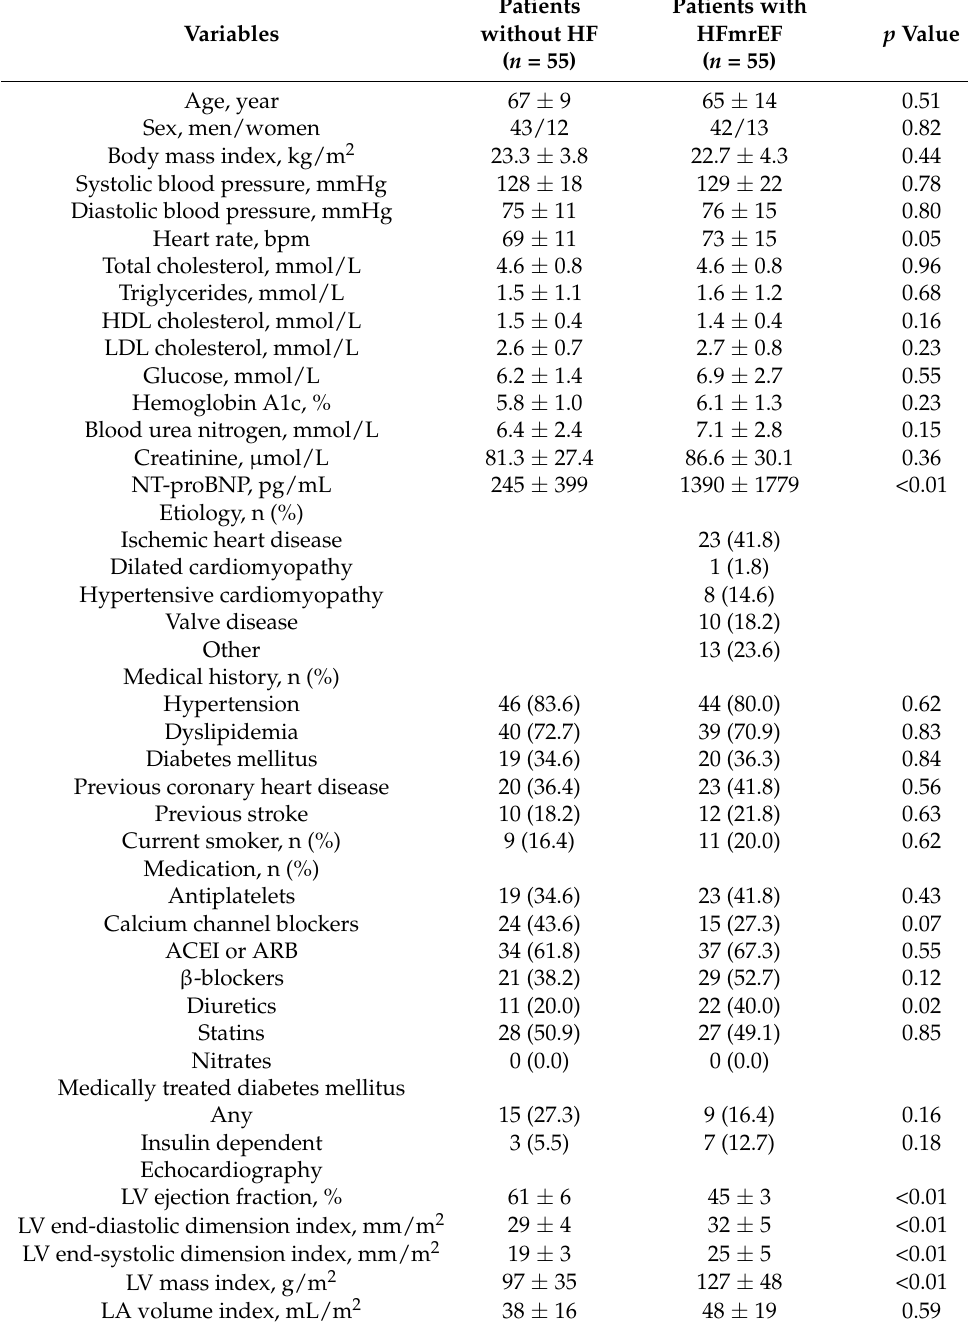
Table 2. Clinical characteristics of well-matched pairs of the subjects correspond to study protocol